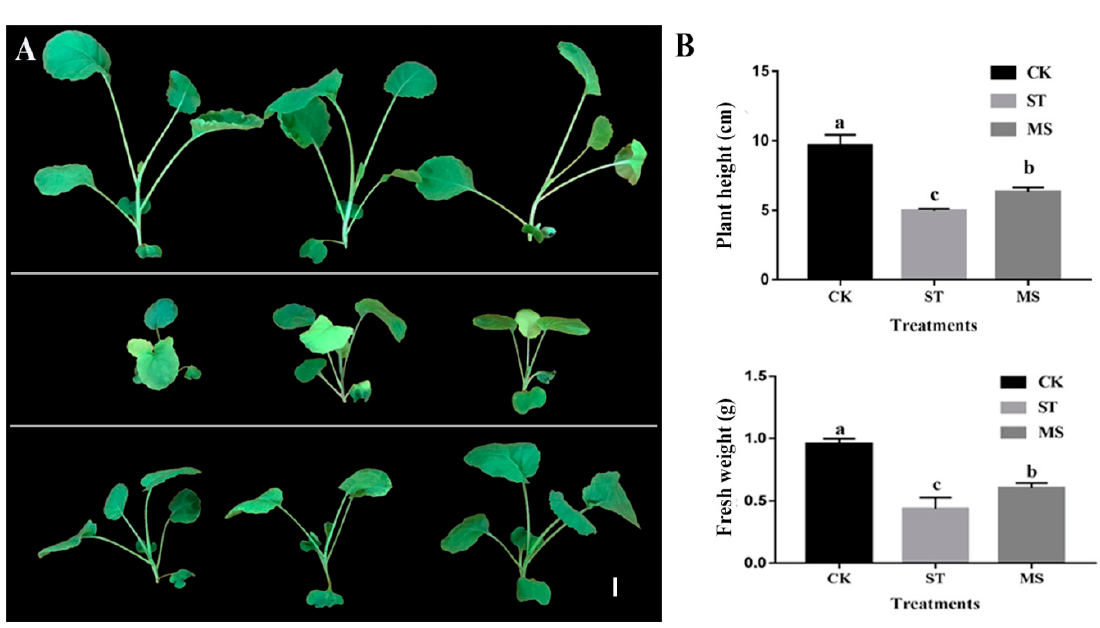
Figure 1. Phenotypes of seedlings under di ff erent treatments. ( A ) The upper, middle, and lower rows show seedlings on the 7th day after CK, ST, and MS treatments, respectively. Bar = 1 cm. ( B ) Comparisons of plant height ( upper-right ) and fresh weight ( lower-right ) among the treatments. Experiments were repeated three times and vertical bars indicate standard errors. CK = Control; ST = 125 mM NaCl; MS = 125 mM NaCl plus 50 µ M melatonin. The a, b, c on the columns represent significant di ff erences at p < 0.05.